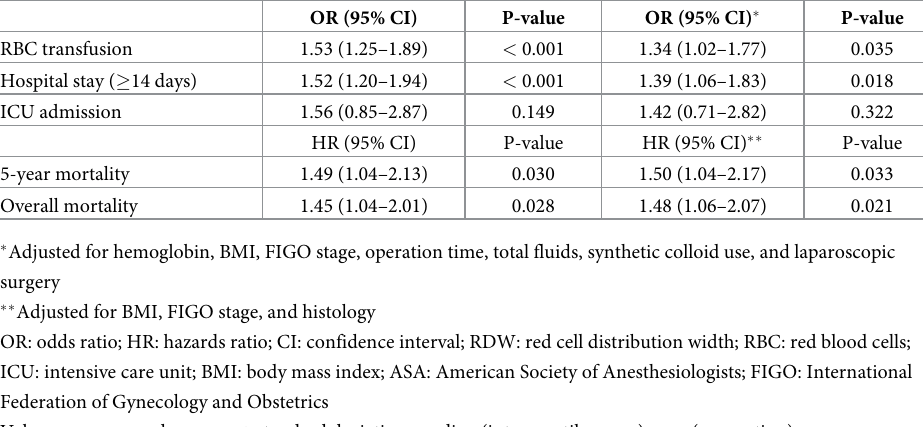
Table 5. Transfusion and surgical outcomes adjusted by RDW/albumin.